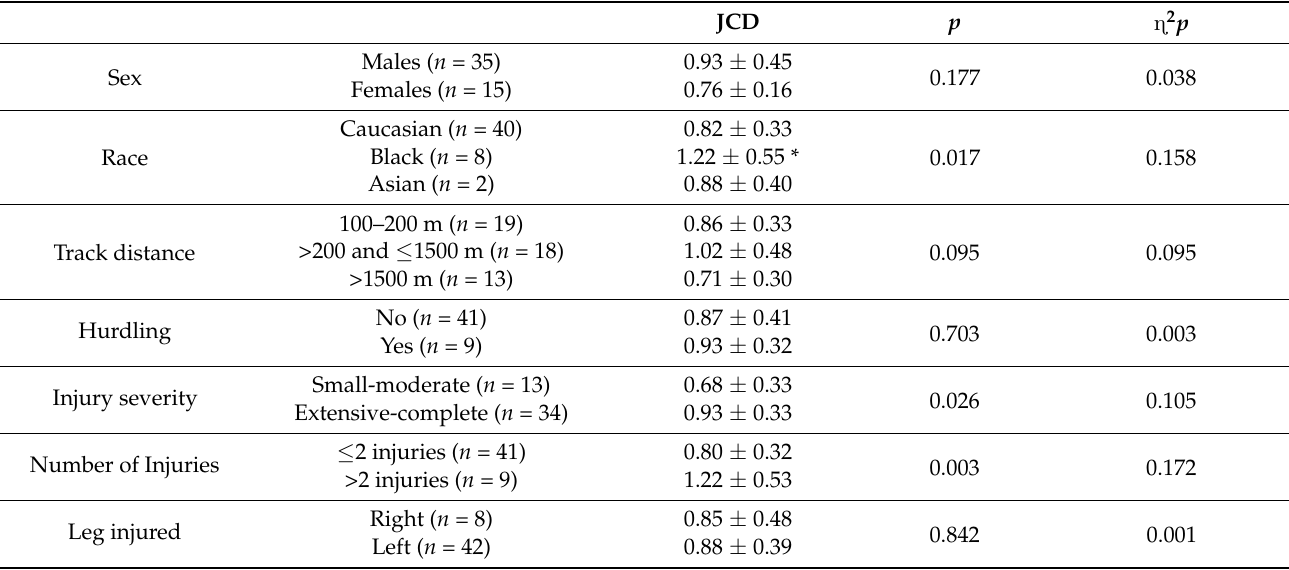
Table 3. Joint clearance discrepancy (JCD) among athletes with a history of injury stratified by sociodemographic character- istics, event type, and nature of the injury.